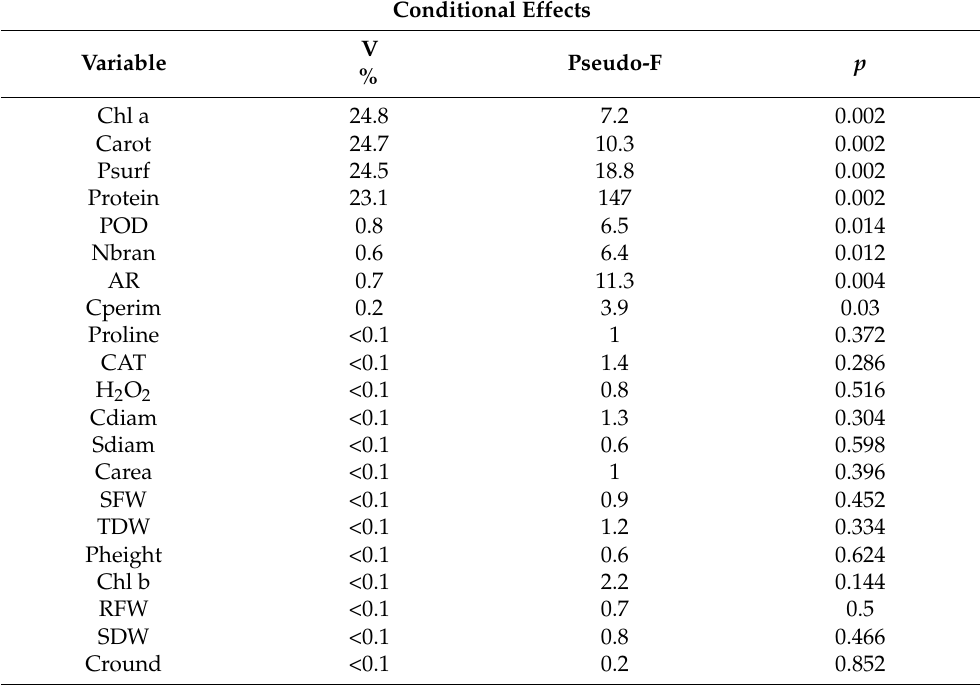
Table 1. Results of discriminant analysis (CVA) with forward selection and Monte Carlo permu- tation test demonstrating relative importance and statistical significance of plant traits in the sep- aration of salt treatments 0, 200, 400, 800, and 1000 mM NaCl. Multi-correlated traits have been automatically